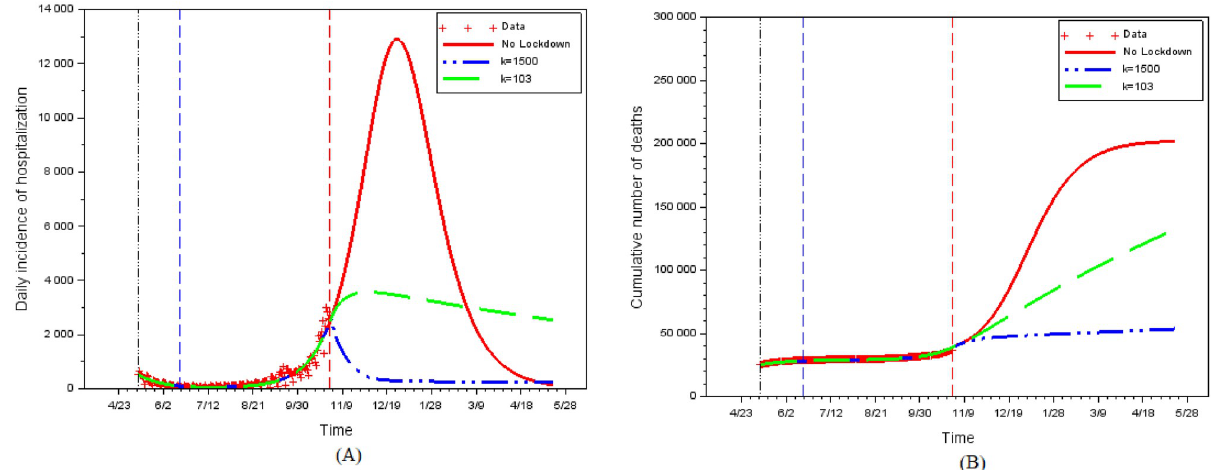
Fig 11. The impact of